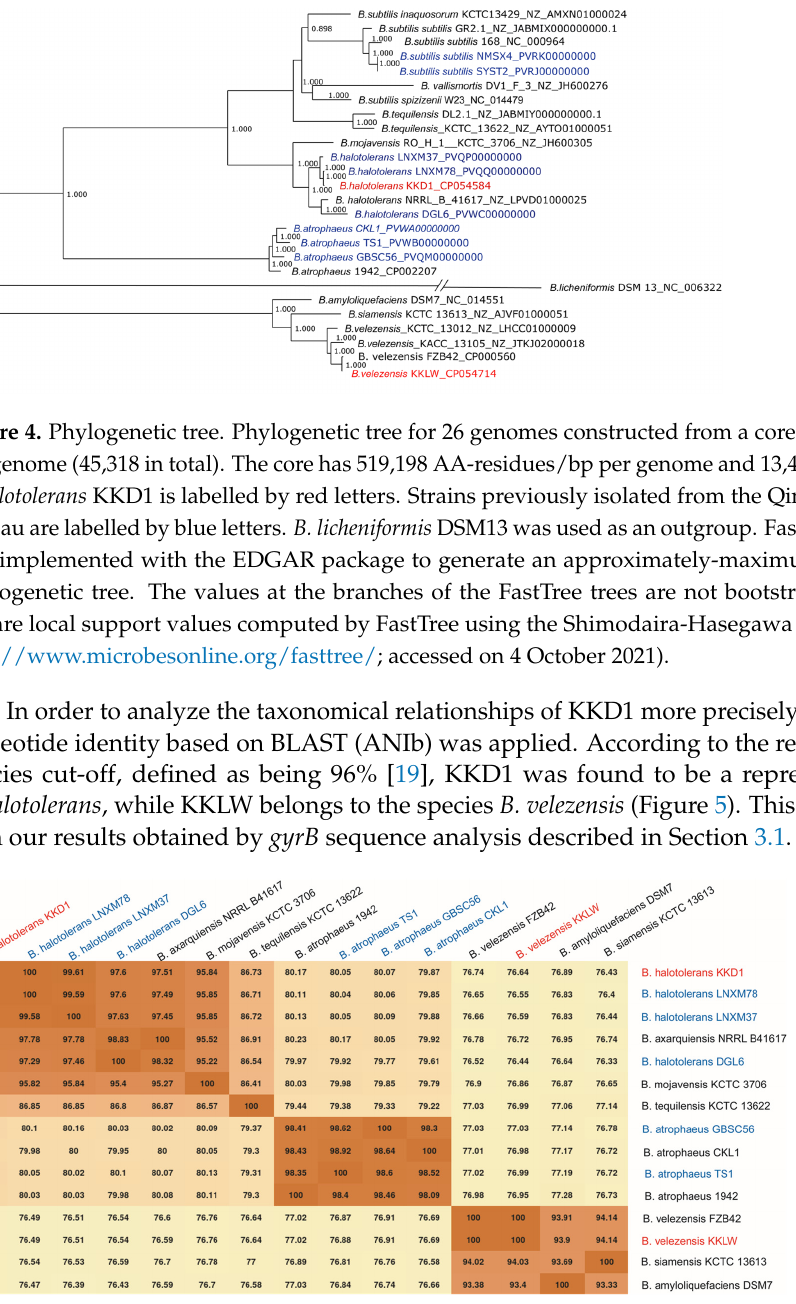
Figure 5. Heatmap of the ANIb matrix calculated for the genomes of B. halotolerans KKD1. Heatmap of the ANIb matrix calculated for the genomes of B. halotolerans KKD1 and closely related species. The method was based on a BLASTN comparison of the genome sequences as described by Goris et al. [20]. B. halotolerans KKD1 is labelled in red letters. Strains isolated from the Qinghai–Tibetan plateau are labelled in blue letters.